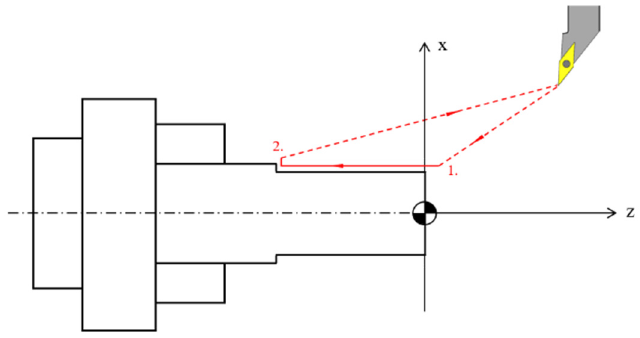
Figure 16. The schematic diagram of outer diameter turning.